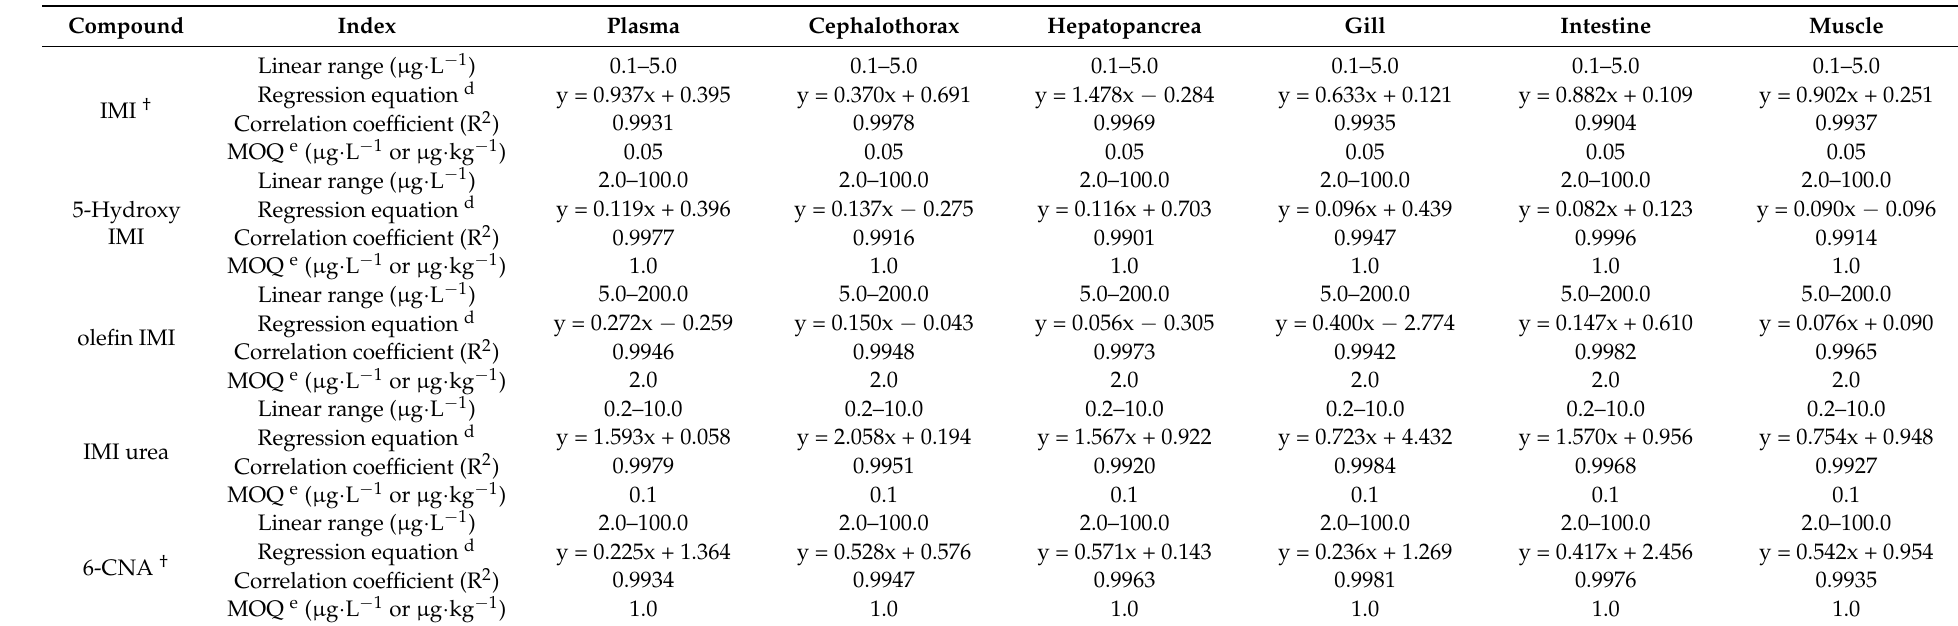
Table 3. Analytical performance of imidacloprid and its metabolites in matrix-matched